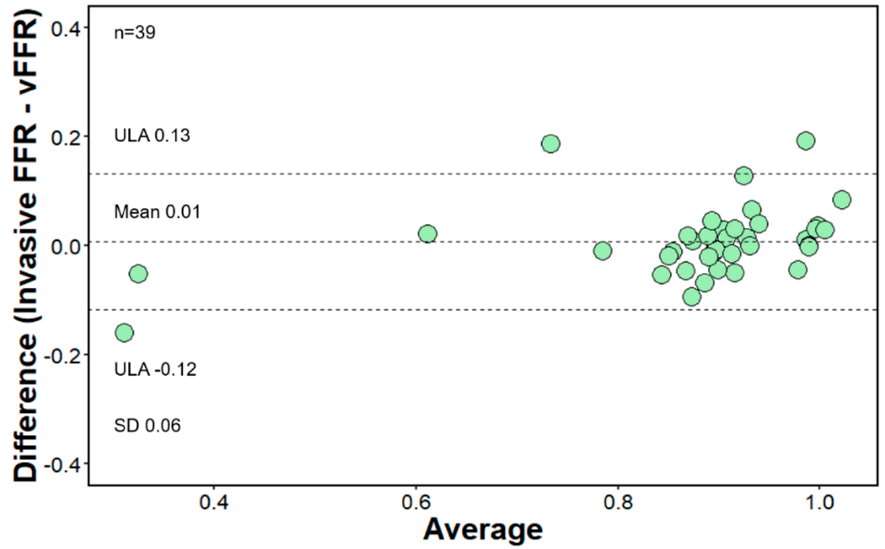
Figure 3. Bland − Altman plot-agreement between invasive FFR and angiography-derived FFR (vFFR). Mean difference 0.01 FFR units, SD ± 0.06, limits of agreement − 0.12 to 0.13.